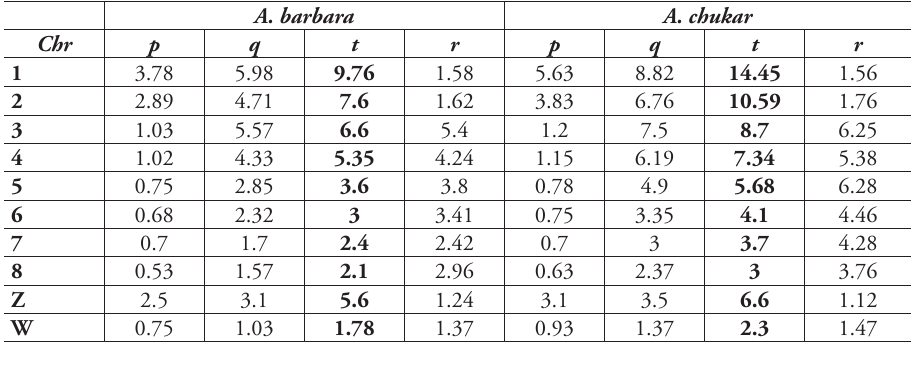
Table 1. A. barbara and A. chukar morphometry of the first eight macrochromosomes and gonosomes. Means are obtained at least from 10 prometaphases/metaphases (from 10 to 20). Chr: chromosome,